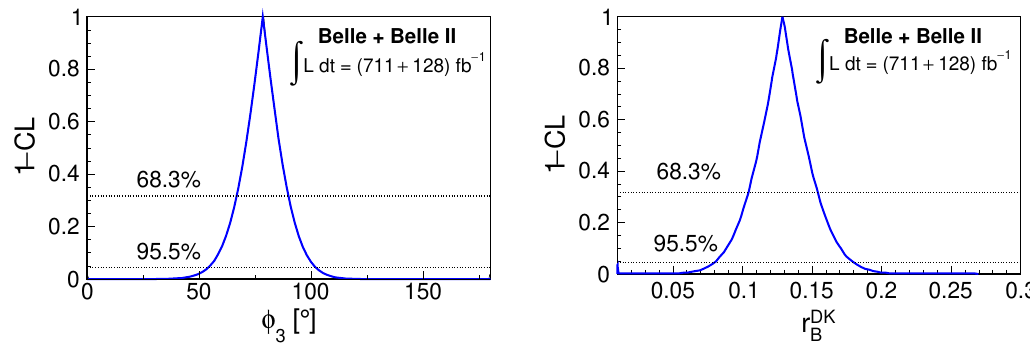
calculated using the methods described B